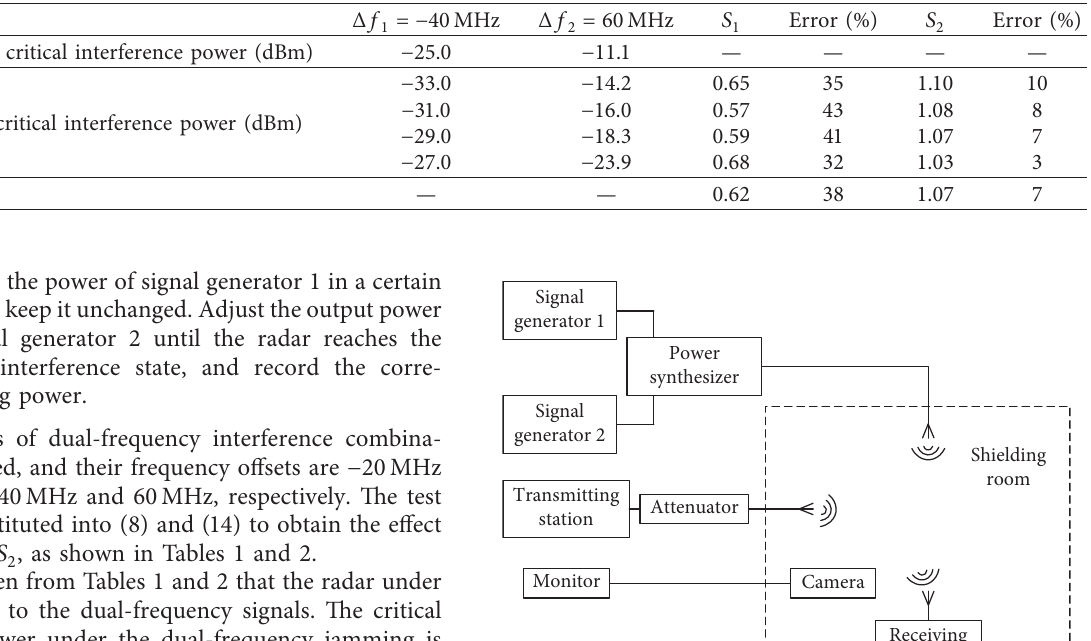
Table 2: Critical interference power when the frequency offset of interference signal is − 40 MHz and 60MHz.